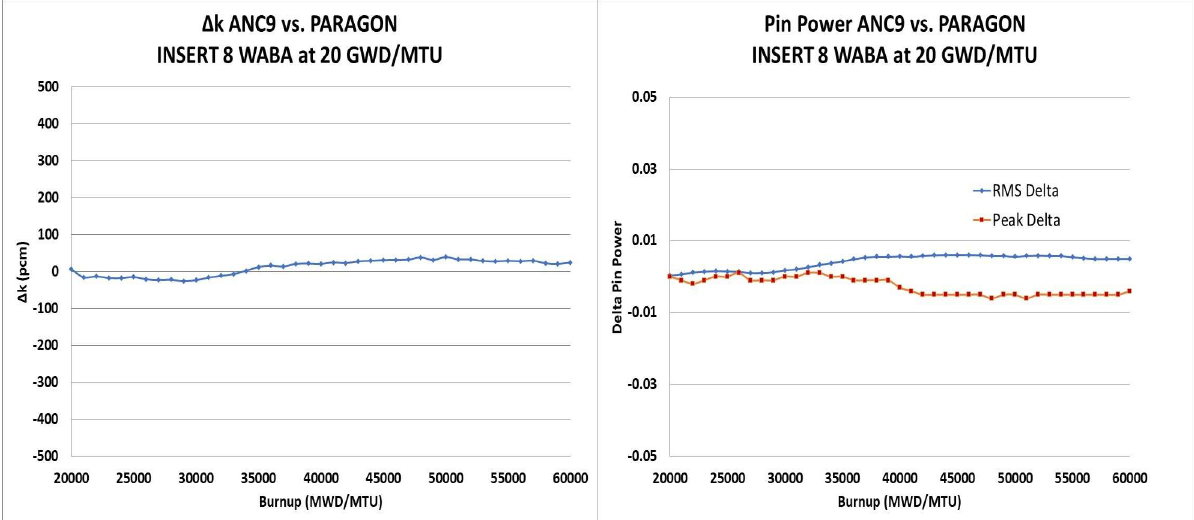
Figure 2. Comparison of eigenvalue and pin power for 8 WABA rods inserted at 20